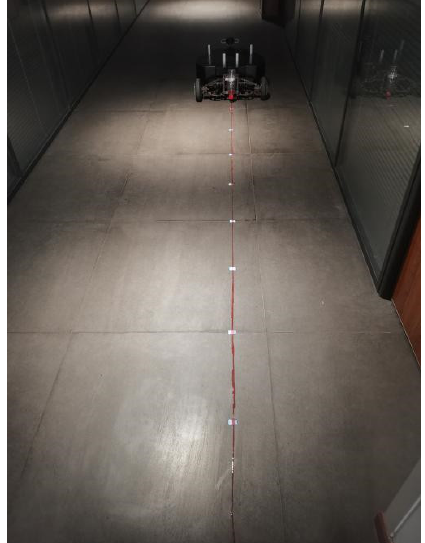
Figure 21. Experiment scene of setpoint parking in the laboratory.